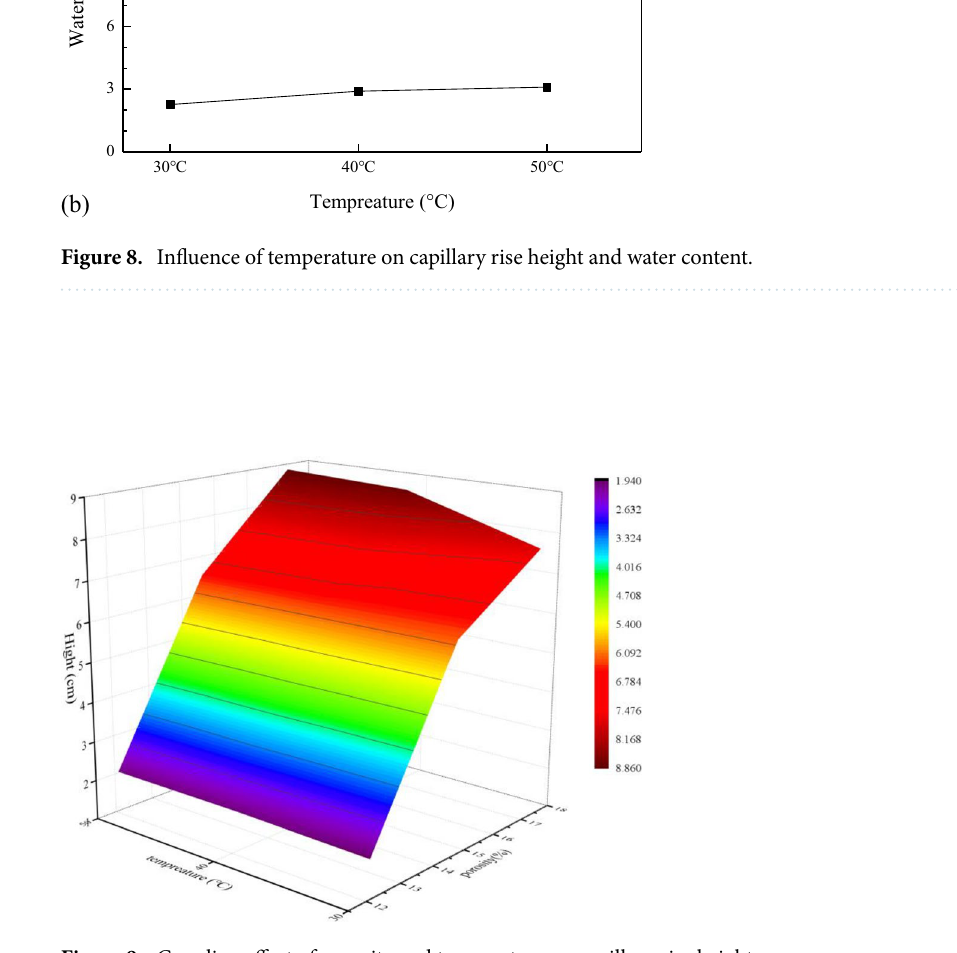
Figure 9. Coupling effect of porosity and temperature on capillary rise